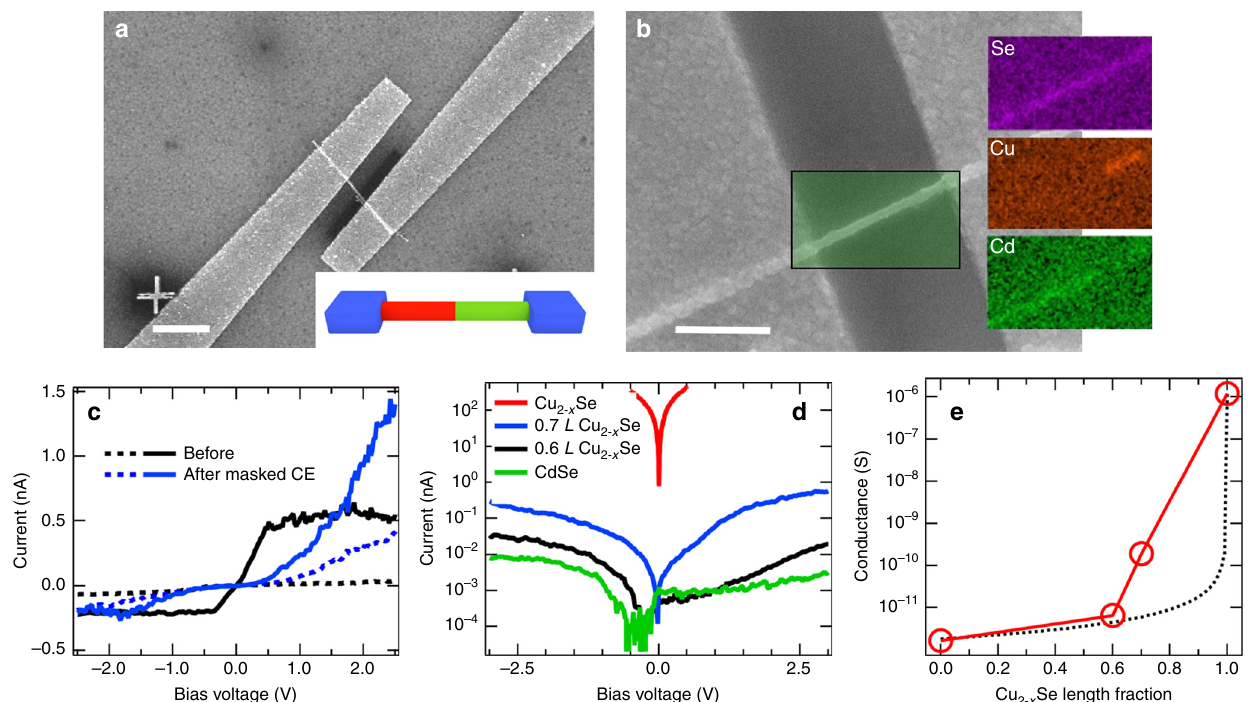
Fig. 6 Electrical properties of single wires. a SEM image of a single NW contacted with two aluminum electrodes. The inset illustrates the heterojunction NW that is obtained after masked CE. Scale bar is 2 µ m. b SEM image with higher resolution and EDS maps showing the Se, Cu, and Cd content of the wire section between the electrical contacts after CE. Scale bar is 500 nm. c Dark and photo IV characteristics of a single CdSe NW before and after the masked CE that converted it into a CdSe/Cu 2 − x Se heterojunction NW. The samples were illuminated with white light at 35 mW/cm 2 . d Current – voltage curves in the dark of a CdSe NW, two heterojunction NWs with 0.6 L and 0.7 L Cu 2 − x Se length fraction (where L is the NW length in between the electrodes), and of a in Supplementary Figure 10. e NW conductance vs. relative length of the Cu 2 − x Se section obtained at a bias voltage of − 3 V, for a wire with diameter of 80 nm and L = 730 nm. The dotted line shows the conductance that would result from two ohmic resistors in